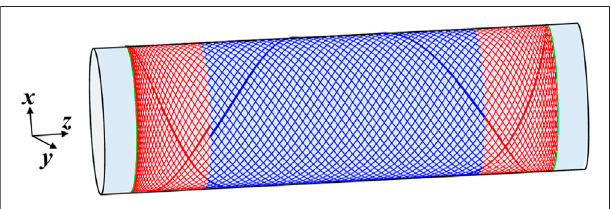
FIGURE 3 | Yarn centerline along all cycles in one